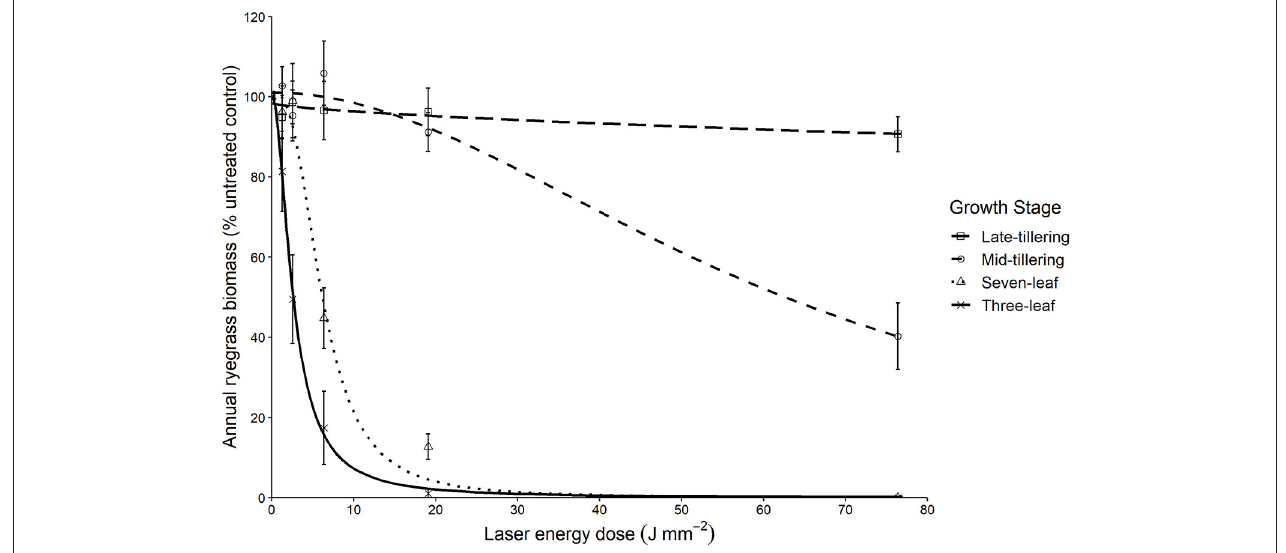
FIGURE 4 | Influence of increasing laser energy density doses on the biomass of annual ryegrass plants when applied at four plant growth stages expressed as the percentage of the untreated control. Growth stages treated included three-leaf, seven-leaf, mid-tillering, and late-tillering. Error bars are provided as standard errors of the mean ( n =